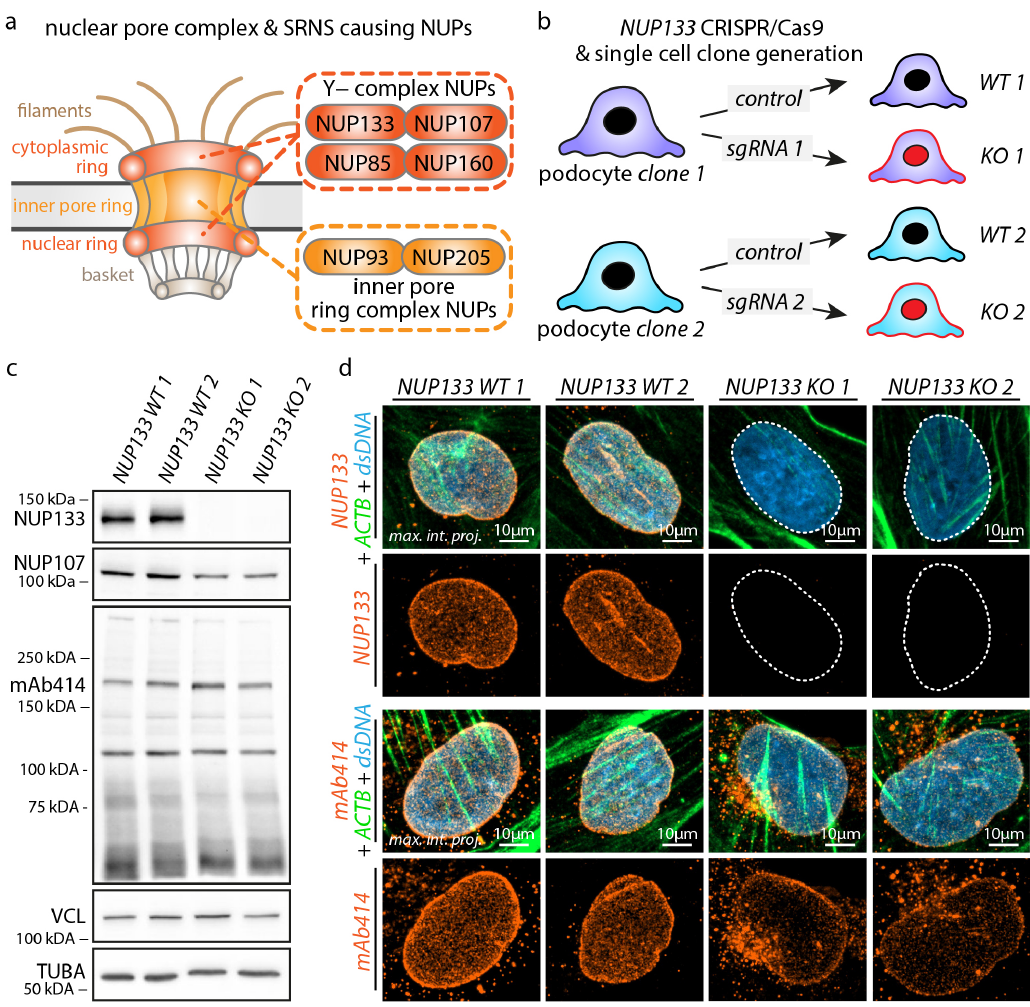
Figure 1. Knockout of NUP133 impairs nuclear pore complex formation in podocytes. ( a ) Schematic of the nuclear pore complex (NPC) and nuclear pore proteins (NUPs), with known causative mutations for steroid-resistant nephrotic syndrome (SRNS). ( b ) Schematic illustrating the generation of two independent monoclonal NUP133 knockout (KO) podocyte cell lines by CRISPR/Cas9 genome editing. ( c ) Western blot analysis confirmed the loss of NUP133 in knockout cell lines and demonstrates the partial degradation of the Y-complex nuclear pore protein NUP107. In contrast, mAb414 (recognizing NUP358, NUP214, NUP153, and NUP62) [48,49] detected no altered protein levels. Vinculin (VCL) and alpha-tubulin (TUBA) served as loading controls. ( d ) Immunofluorescence analysis of mature NPCs in the nuclear envelope, by NUP133 and mAb414, confirmed loss of NUP133 expression and strongly reduced formation of mAb414 positive NPCs in the nuclear envelope. Concomitant increase of mAb414 positive vesicles in the cytoplasm was observed. Nuclei (dsDNA) were co-stained by Hoechst 33342 and whole cells by beta-Actin (ACTB). Dotted lines indicate the nuclear circumference; maximum intensity projections of z-stacks from whole nuclei are